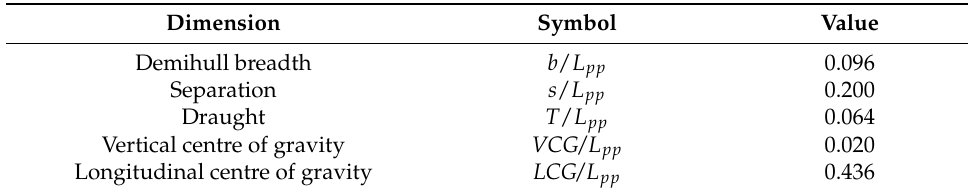
Table 2. Main dimensions of the NPL 4a02 catamaran.